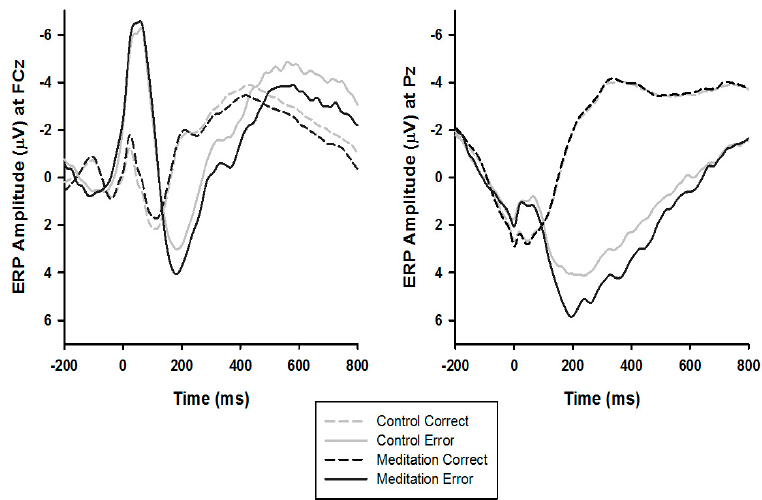
Figure 1. Grand average waveforms as a function of group representing the error-related negativity (ERN; left) averaged across frontocentral electrode site FCz and the error positivity (Pe; right) averaged across central electrode site Pz.